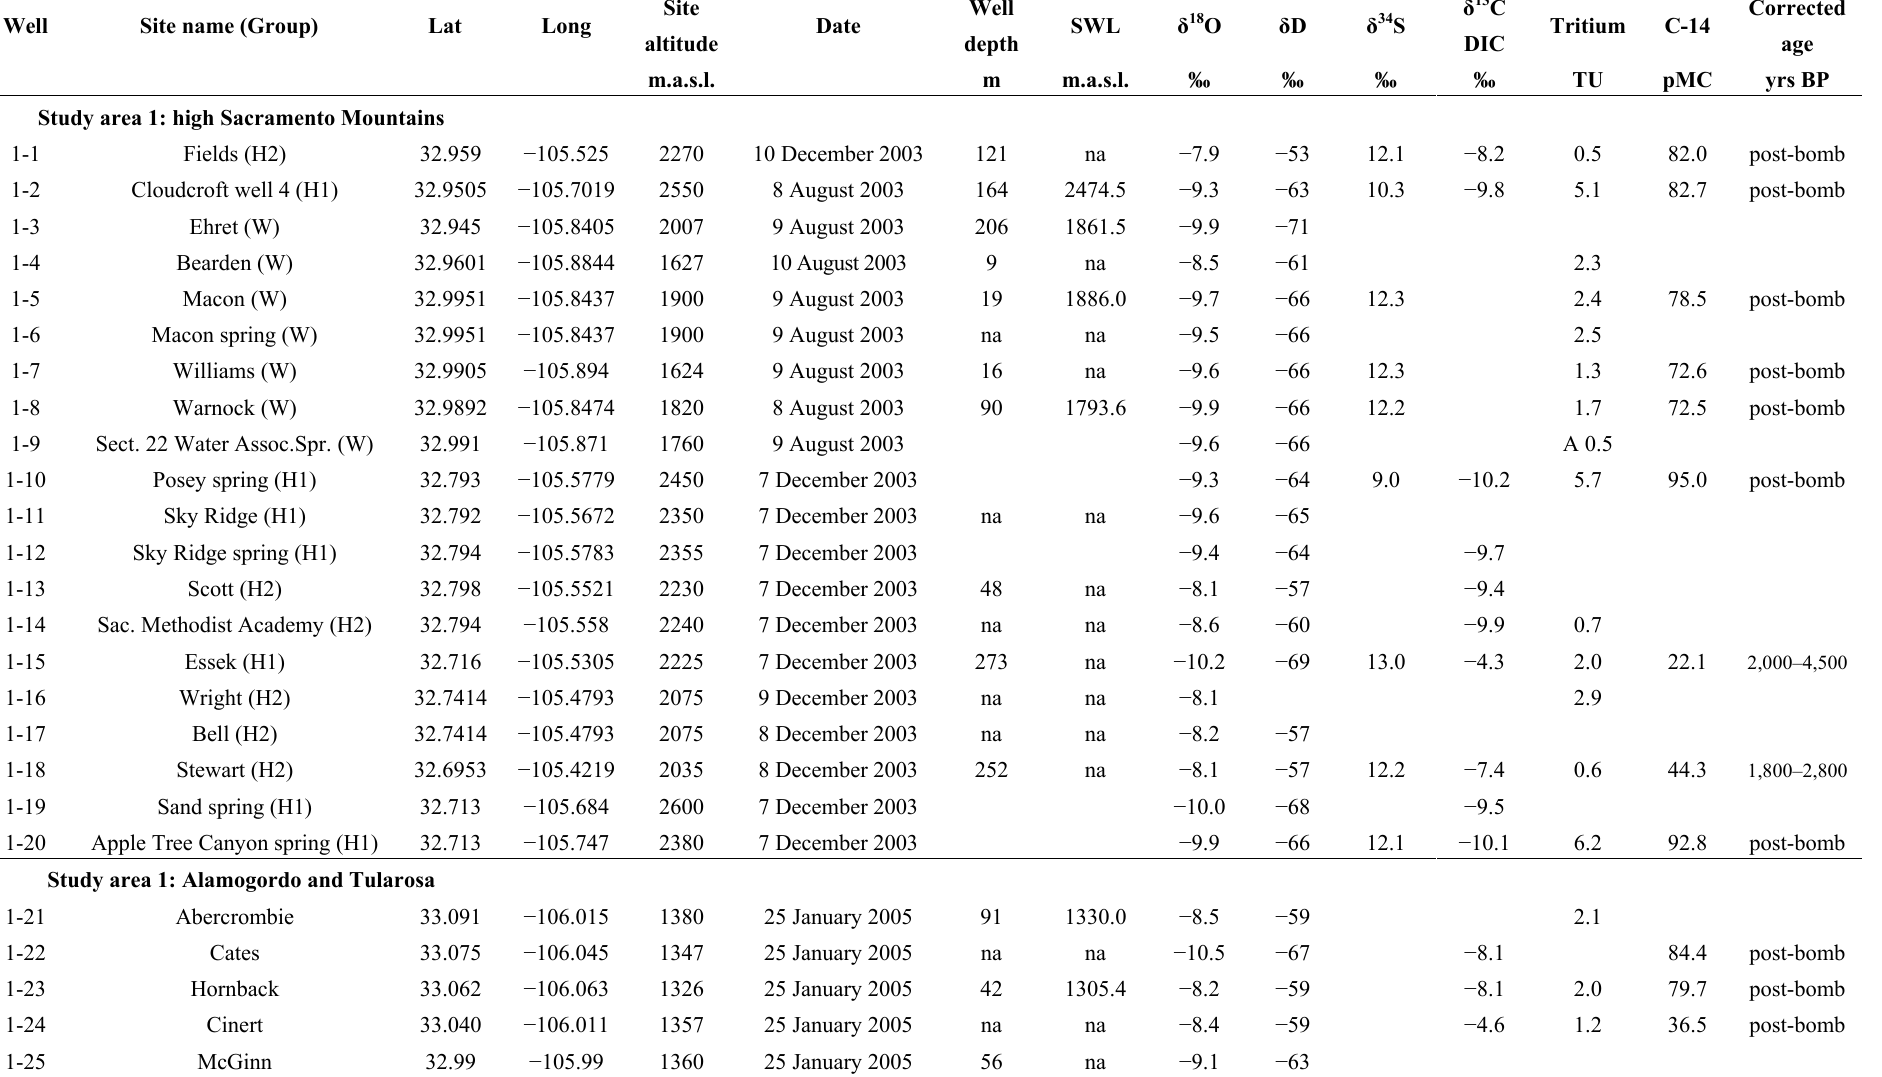
Table 1. Site information and isotope